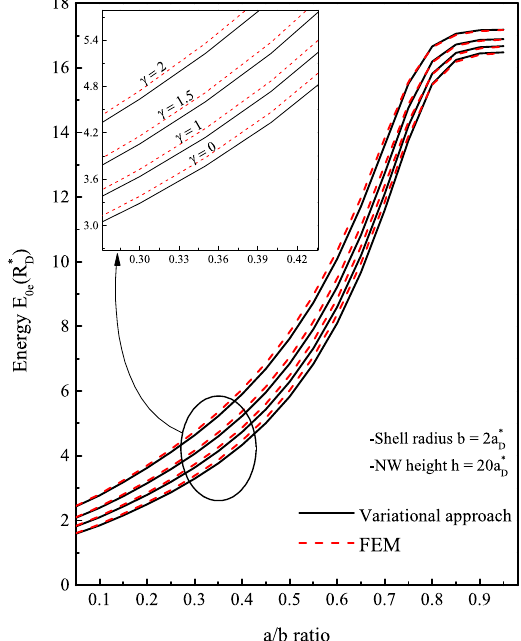
Figure 2. Electron ground state energy of Al x Ga 1 − x As/GaAs core/shell NW with x = 0.1 calculating via variational method (solid line) according to Equation (10) and via FEM implemented in COMSOL Multiphysics (dashed line). The FEM is used by modeling the Schrödinger equation H 0 e ( B ) ψ e ( ρ e ) = E 0 e ( B ) ψ e ( ρ e ) with Partial Differential Equations model. The results of the two methods are sufficiently consistent. The core radius was varied by the ratio ( a / b ) and three cases of the applied magnetic field are considered: γ = 1,1.5 and